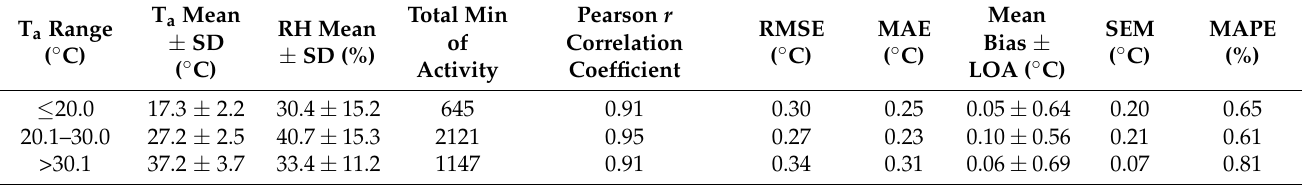
Table 4. Kenzen T C algorithm accuracy binned by environmental